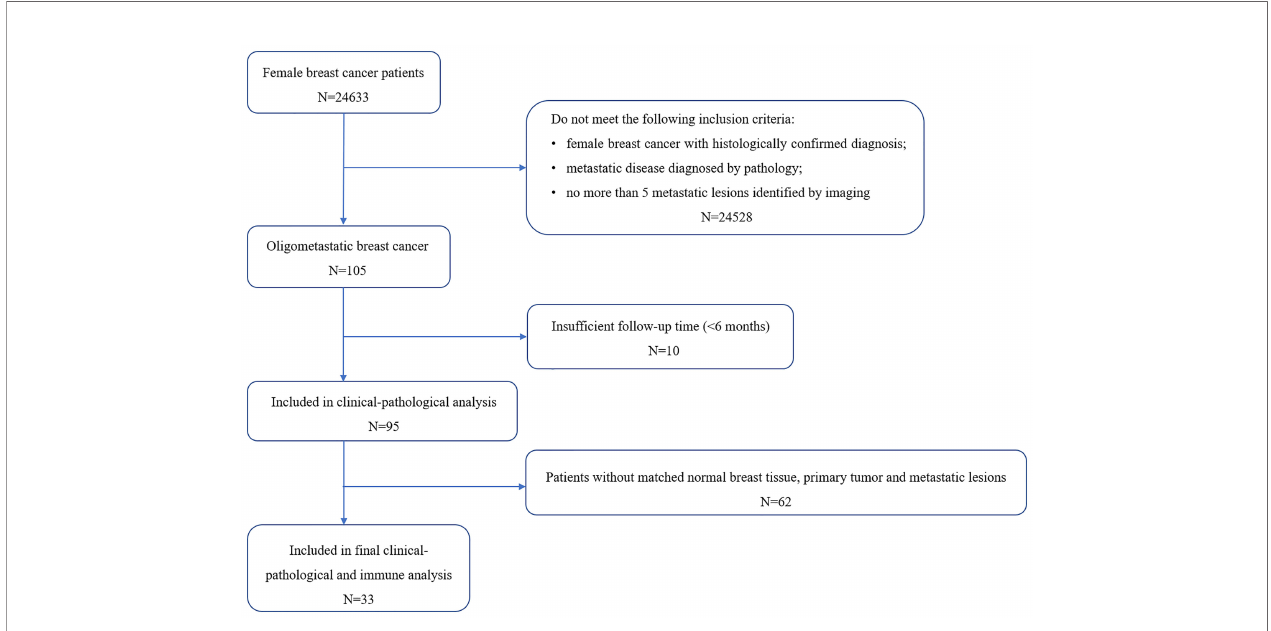
FIGURE 1 | A fl ow chart outlining included patients ’